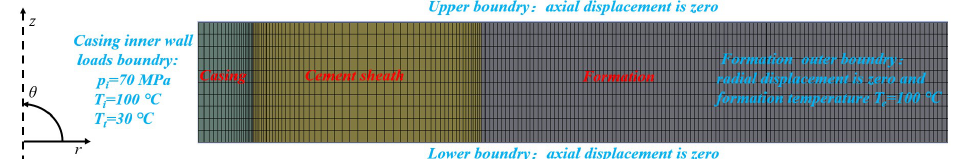
Figure 3. The 2D axisymmetric finite element analysis model of casing-cement sheath-formation system.